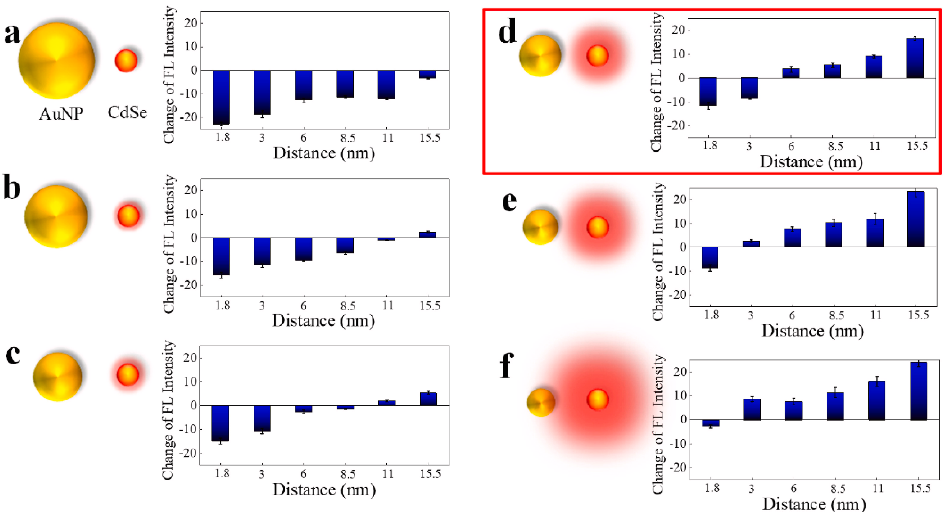
Figure 9. Fluorescence spectral bar diagram of CdSe QDs in various CdSe QD-peptide-AuNP nanoconjugates. Six different sizes of AuNPs at 80 ( a ), 60 ( b ), 45 ( c ), 35 ( d ), 25 ( e ), and 15 nm ( f ) combined with six different peptide lengths produced various fluorescence intensity changes. Reprinted with permission obtained from [104].